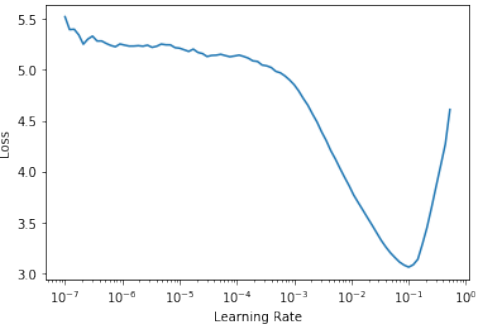
Figure 9. The learning rate finder does a mock training with an exponentially growing learning rate over 100 iterations. A good value is then the minimum value on the graph divided by